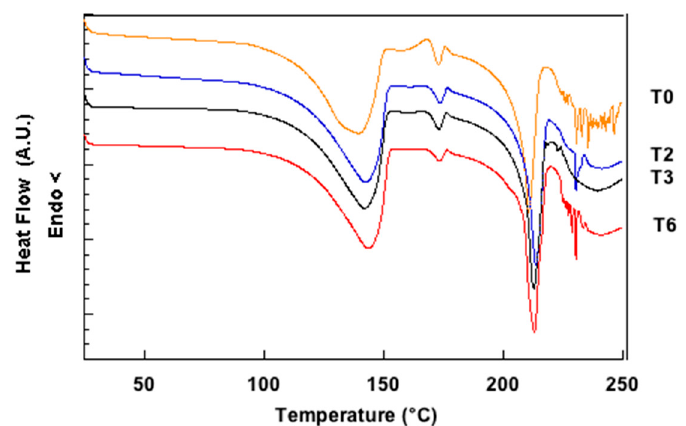
Figure 3. Differential scanning calorimetry (DSC) traces of micronized lactose recorded immediately after production (T0), after two (T2), three (T3), and six (T6) months storage at 25 °C, 60% RH.